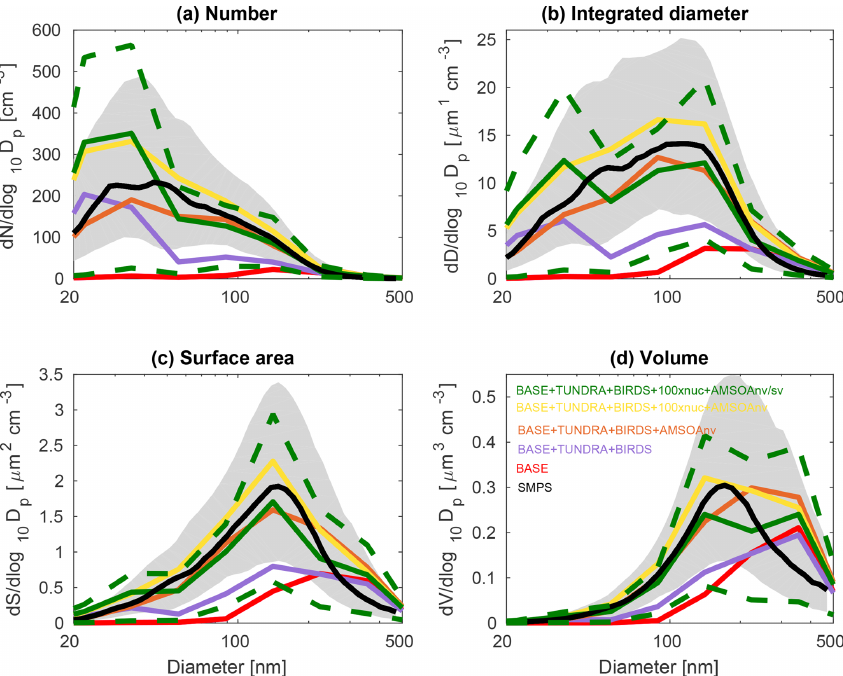
Figure 3. July and August 2016 median aerosol size distributions from scanning mobility particle sizer (SMPS) measurements at Alert (82.5 ◦ N, 62.3 ◦ W; black; described in Sect. 2.1) and for five GEOS-Chem-TOMAS simulations (color coded as shown in the leg- end). Grey shading shows the SMPS 20th to 80th percentile and the green dashed lines show the 20th to 80th percentile for the BASE + TUNDRA + BIRDS + 100xnuc + AMSOAnv/sv simulation. Simulations are described in Table 1 and Sect. 2.3. The panels show the aerosol distribution moments with respect to (a) the aerosol number, (b) the integrated aerosol diameter, (c) the aerosol surface area, and (d) the aerosol volume distributions. Note the different vertical scale relative to Figs. 4 and